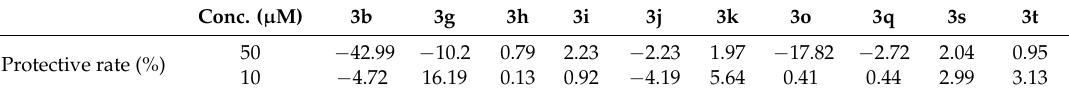
Table 4. The protective rate of compounds on MPP + -induced SH-SY5Y cells.